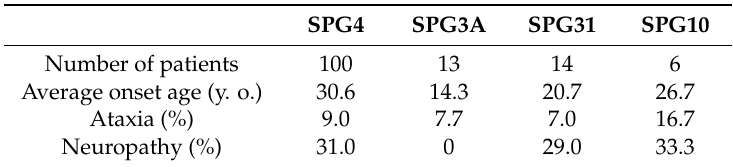
Table 2. Clinical information on common